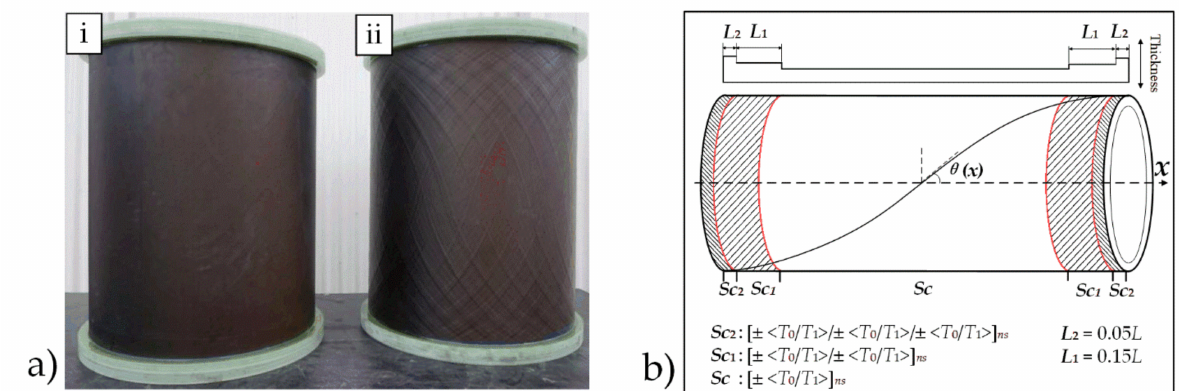
Figure 6. The overlap and the configuration of simulation model: ( a ) i: the CS cylinder and ii: the VS cylinder with overlap, reproduced with the permission of ref. [26], copyright@Elsevier, 2019 and ( b ) the configuration of the overlap